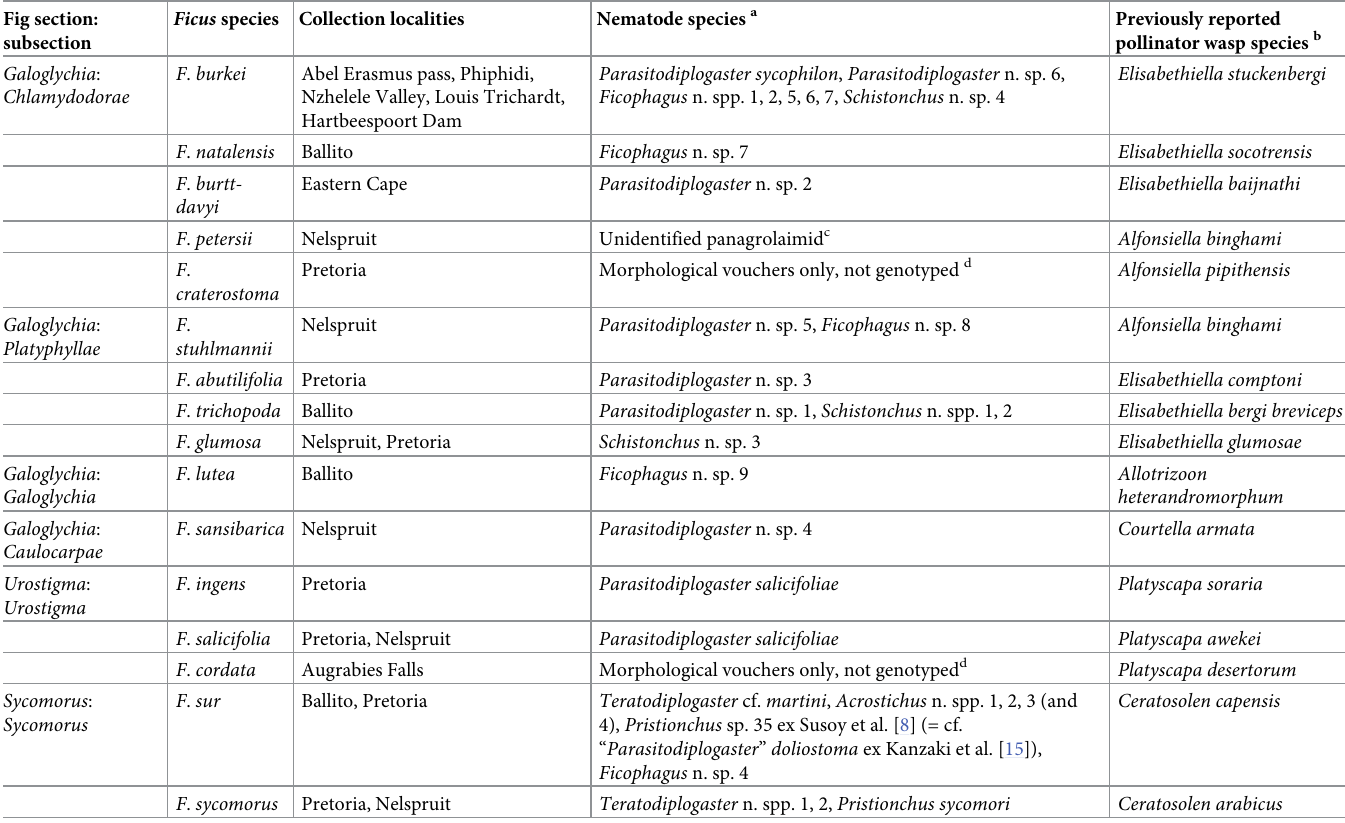
Table 1. Host, locality and recovered nematode species from dissected fig syconia. Fig section: